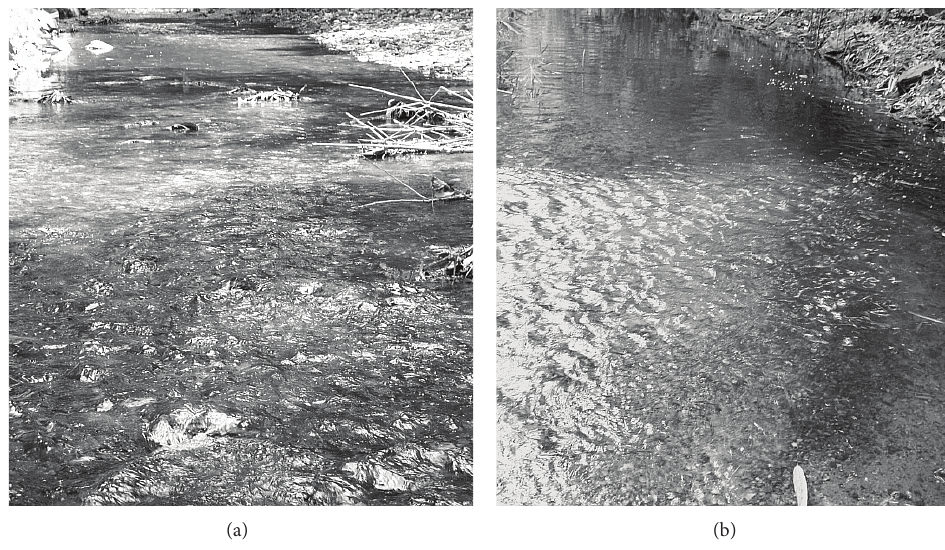
Figure 4: (a) Maracas-St. Joseph River downstream sample site and (b) upstream sample